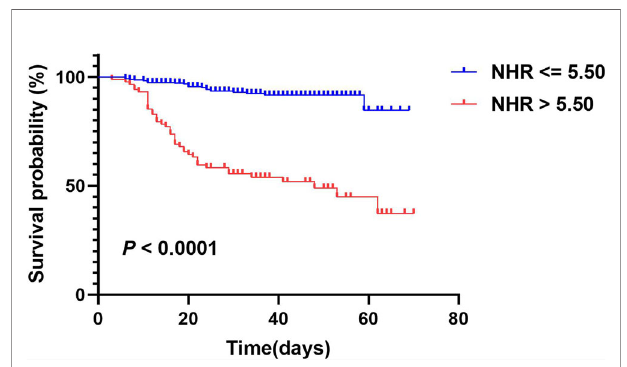
FIGURE 2 | Kaplan-Meier survival curves for primary composite endpoint according to NHR optimal cutoff value. A log-rank test was used to evaluate difference between groups.